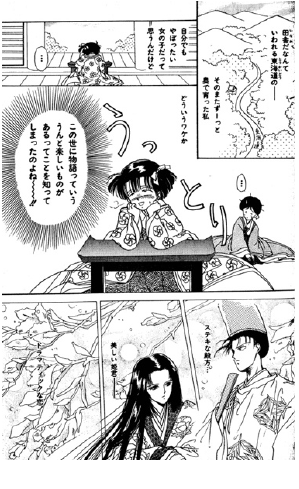
Figure 4. Sara-chan dreams of “dramatic” romance (Hazaki 1991, 13). Courtesy of